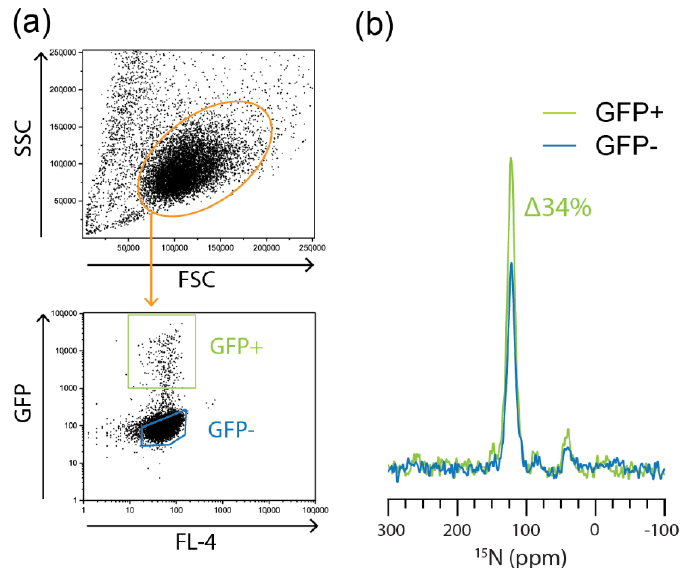
Figure 5. Increased cellular homogeneity using flow cytometric sorting. ( a ) Flow cytometry gating strategy for the GFP sorting of TNF-α-activated JLat 9.2 cells. Side scatter (SSC) and forward scatter (FSC) profiles were used to gate live cells. ( b ) 15 N DNP-NMR spectra of 3 × 10 6 GFP+ and GFP− cells.